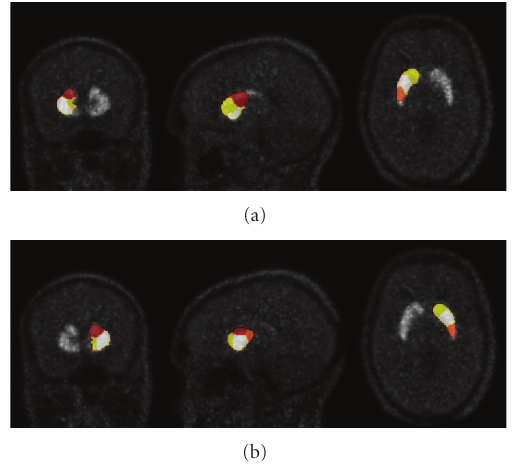
Figure 5: Segmentation result using the automatic method: (a) left striatum and (b) right striatum. In both images (a), (b), the orange and white clusters correspond, respectively, to the posterior and the anterior putamen, the red cluster corresponds to the caudate and, the yellow cluster corresponds to the ventral striatum and a part of the caudate head.